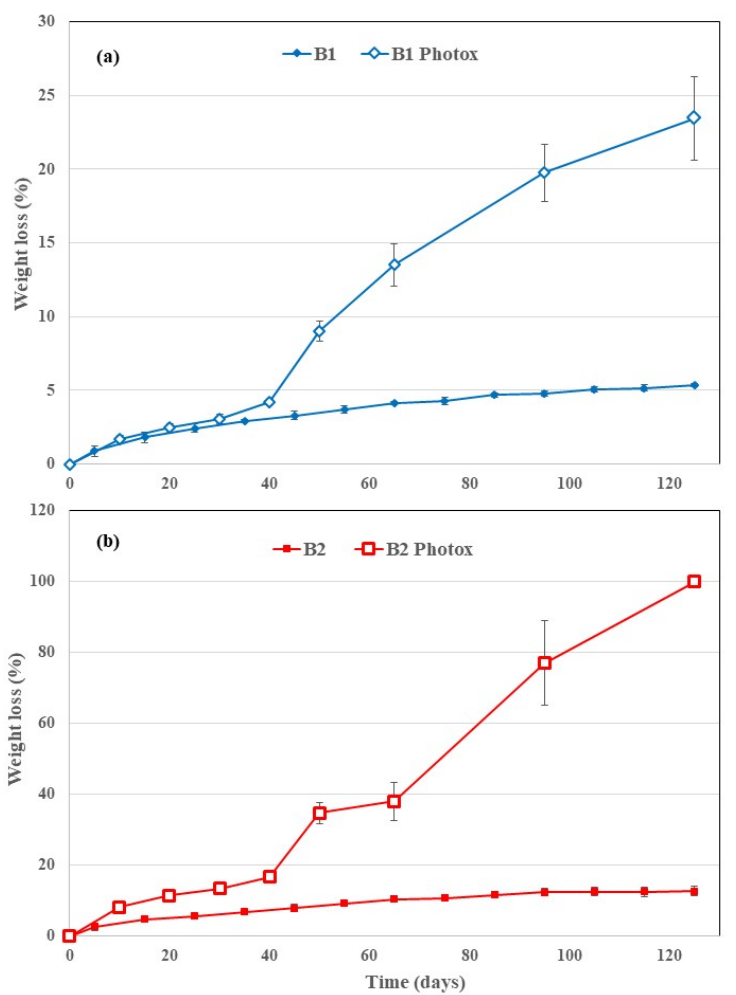
Figure 4. Average weight loss values (%) vs. degradation time for the film samples ( a ) B1 and ( b ) B2, virgin and photo-oxidized.